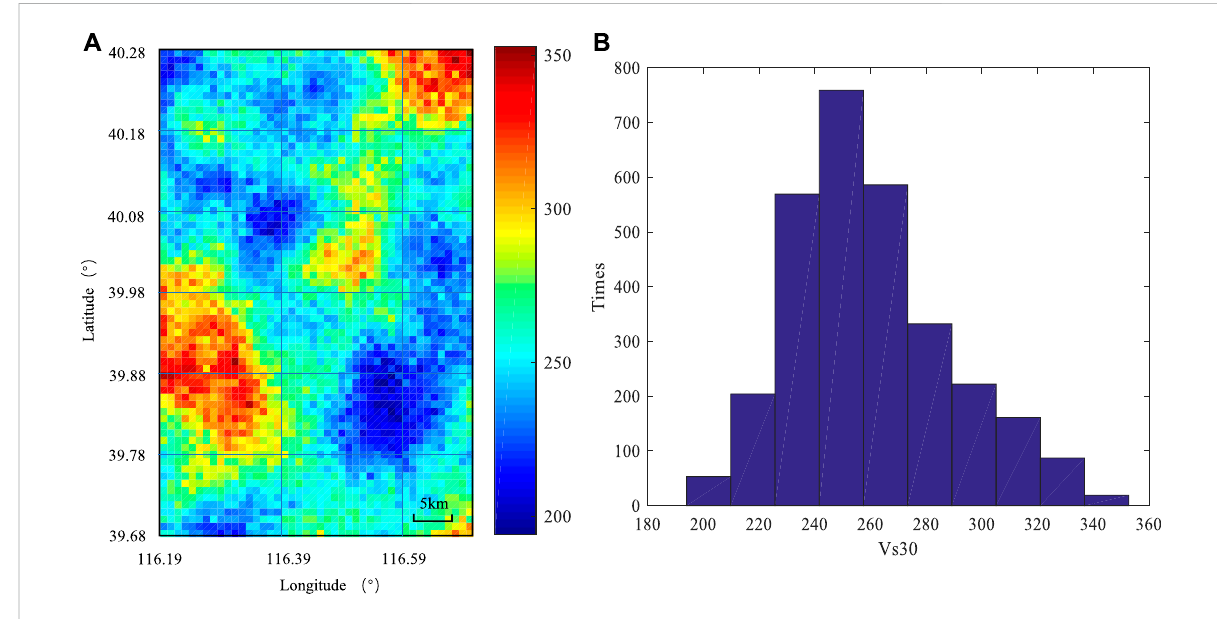
One-time random fi eld realization of V s30 in the Beijing area. (A) Map of V s30 realization; (B) Histogram of V s30 .